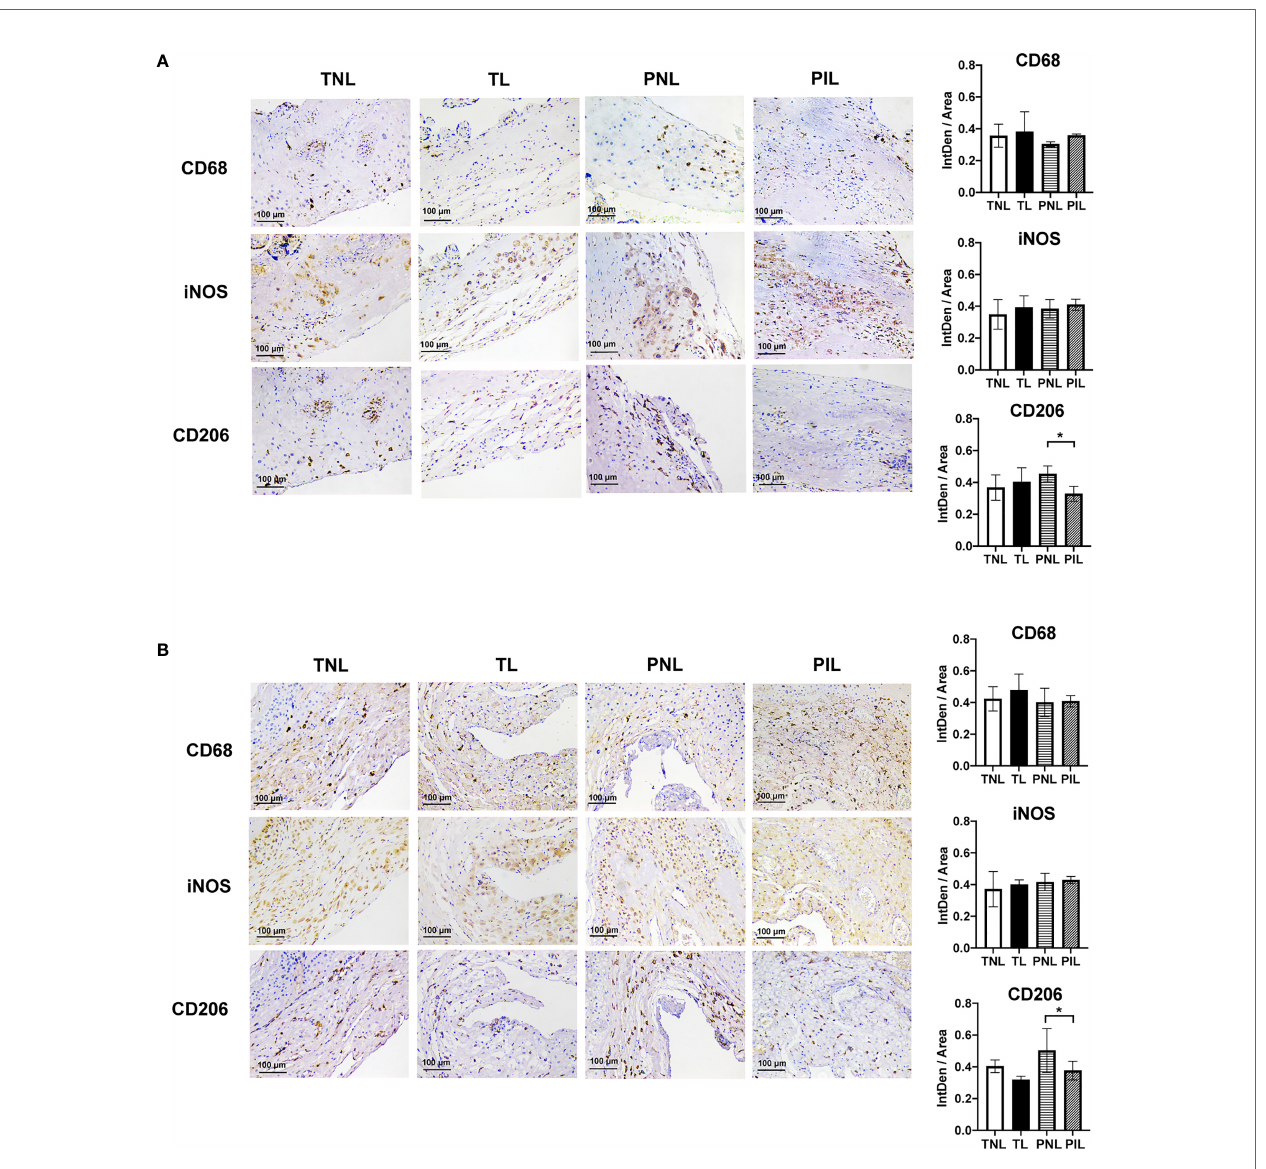
FIGURE 3 | IHC Staining of Macrophages Markers in the Decidua basalis and Parietalis during Term and Preterm Labor. (A) Comparison of the expression of CD68, iNOS, and CD206 in the decidua basalis tissue among the four groups. (B) Comparison of the expression of CD68, iNOS, and CD206 in the decidua parietalis tissue among the four groups. Continuous variables were presented as mean ± standard deviation. Differences are indicated: * P < 0.05. IntDen: Integrated